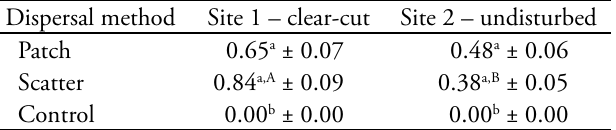
Table 2. Fraction of Cladonia stellaris cover in relation to the total reindeer lichen cover in the experimental plots in 2008 (mean ± SEM). Different lower case letters within col- umns indicate significant between-treatment differences (Tukey’s test: P <0.05); different capital letters within lines indicate significant between-site differences (Paired t -test: P <0.05).